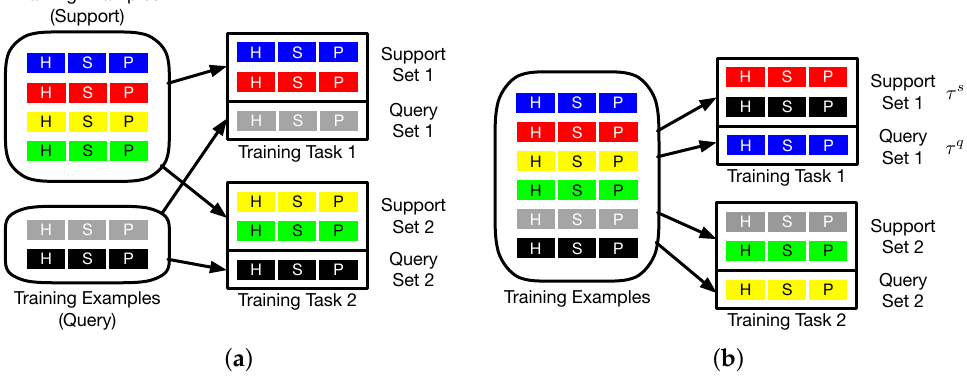
Figure 3. The selection of examples in the meta-training phase. Left: MAML. Right: Our algorithm. H, S, and P represent the MRI images from the heart, spleen, and prostate, respectively. Each example is displayed by a particular color. ( a ) MAML; ( b )